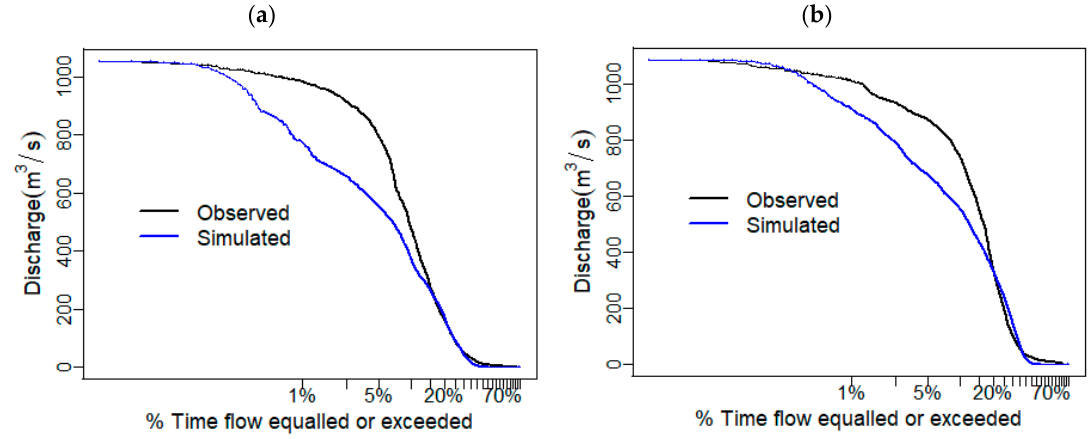
Figure 11. Flow duration curve of daily observed and simulated discharge in calibration over 1971–1990 ( a ) and validation over 1991–2010 ( b ).